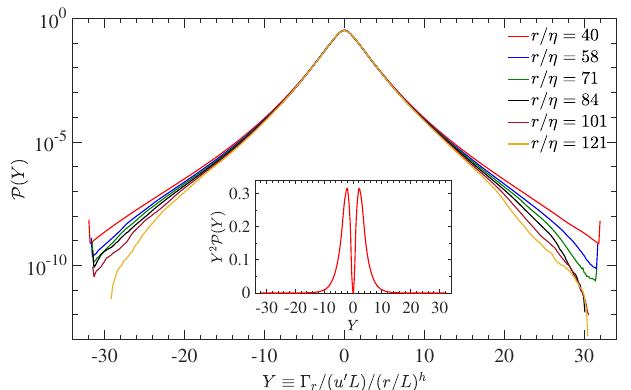
FIG. 9. Compensated probability density function of the normalized circulation Y , with scaling exponent h ¼ 1 . 1 and dimension D ¼ 2 . 2 , for different inertial range separations, at R ¼ 1300 . The upticks at the tails of the PDFs are due to finite λ sampling. Inset shows the integrand of h Y 8 i for a typical inertial separation, demonstrating that the dominant contribution to higher-order circulation moments comes from the collapsed region. This plot confirms that the higher-order circulation moments follow the scaling λ p ¼ hp þ ð 3 − D Þ , with the Hölder exponent h ¼ 1 . 1 and fractal dimension D ¼ 2 . 2 .